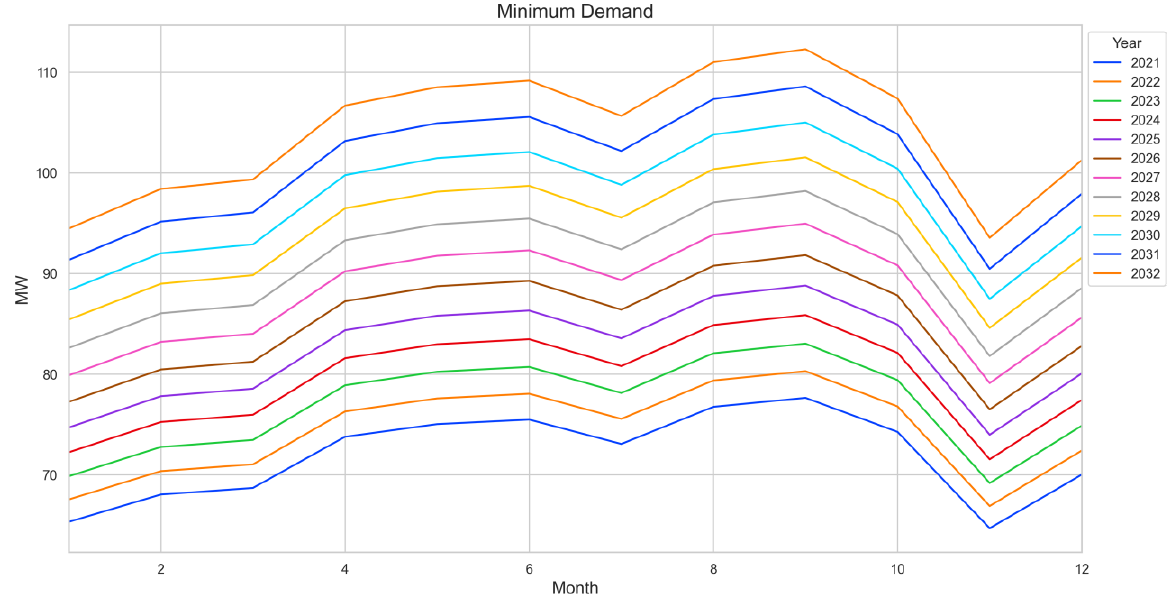
Figure 9. Growth of demand considering a low-projection future from 2017 to 2030.